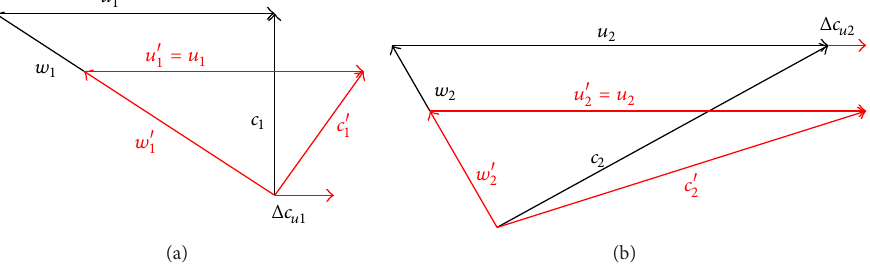
Figure 1: Velocity triangles for zero (black) and positive preswirl (red with primes) at different mass flow rates: (a) impeller inlet, (b) impeller exit.